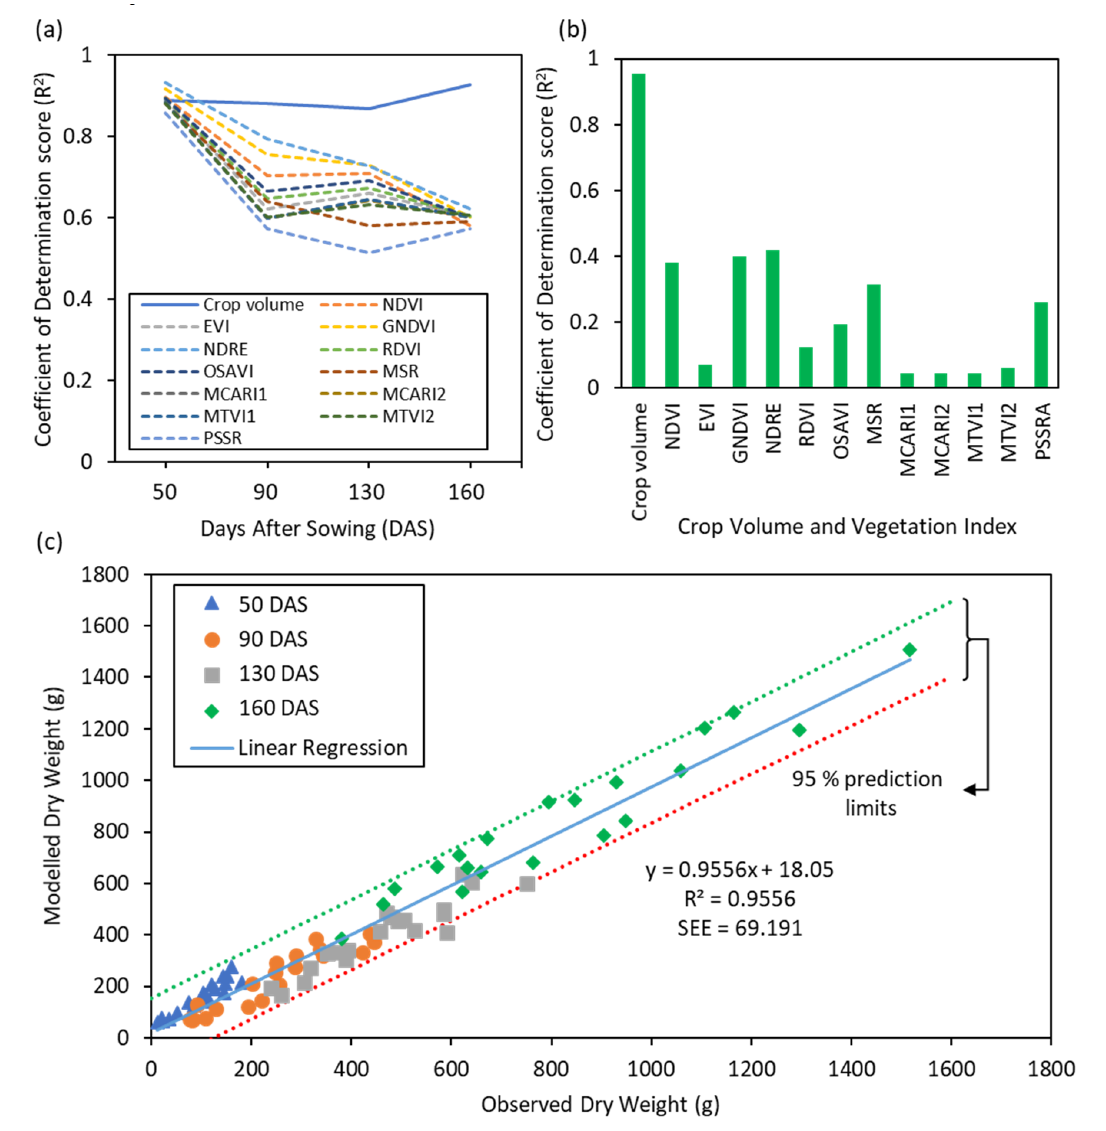
Figure 5. Estimation of dry biomass or dry weight (DW): Variability in the correlation of determination (R 2 ) for modelling performed using crop volume (CV) and standard vegetation indices ( a ) across di ff erent time points and ( b ) at all the time points combined against observed DW; ( c ) Modelling results for DW derived from CV against observed DW data.